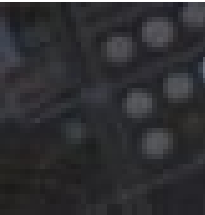
Figure 3. Misleading building: The building on the left is roughly similar to the tanks on the right.